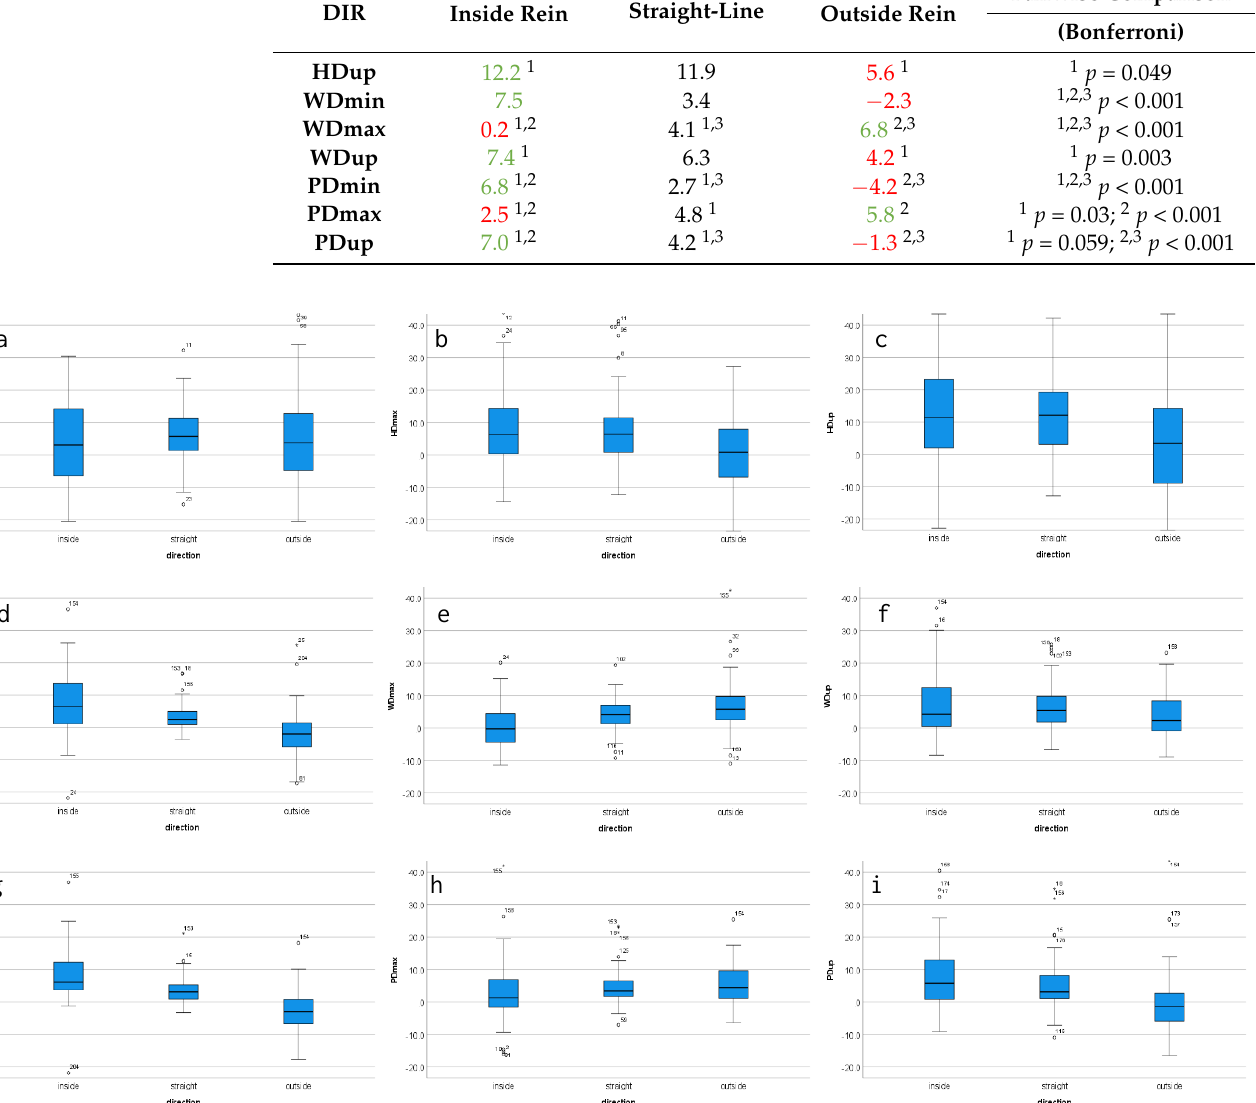
Table 4. Estimated marginal mean (EMM) values for fixed factor movement direction (DIR) for the seven affected asymmetry parameters. All values in mm. Values marked with same index have pairwise significant difference (Bonferroni). The highest value for each asymmetry parameter is given in green, the lowest value in red. DIR Inside Rein Straight-Line Outside Rein